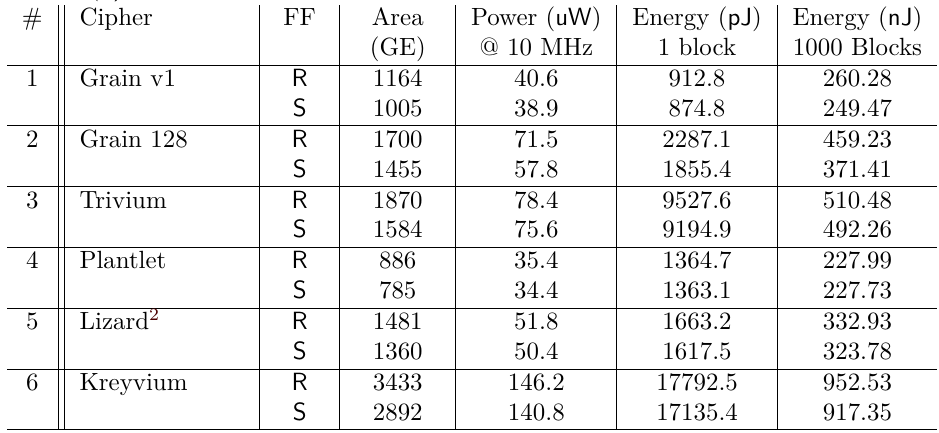
Table 1: A comparison of energy consumptions when using regular flip-flops ( R) and scan flip-flops ( S)